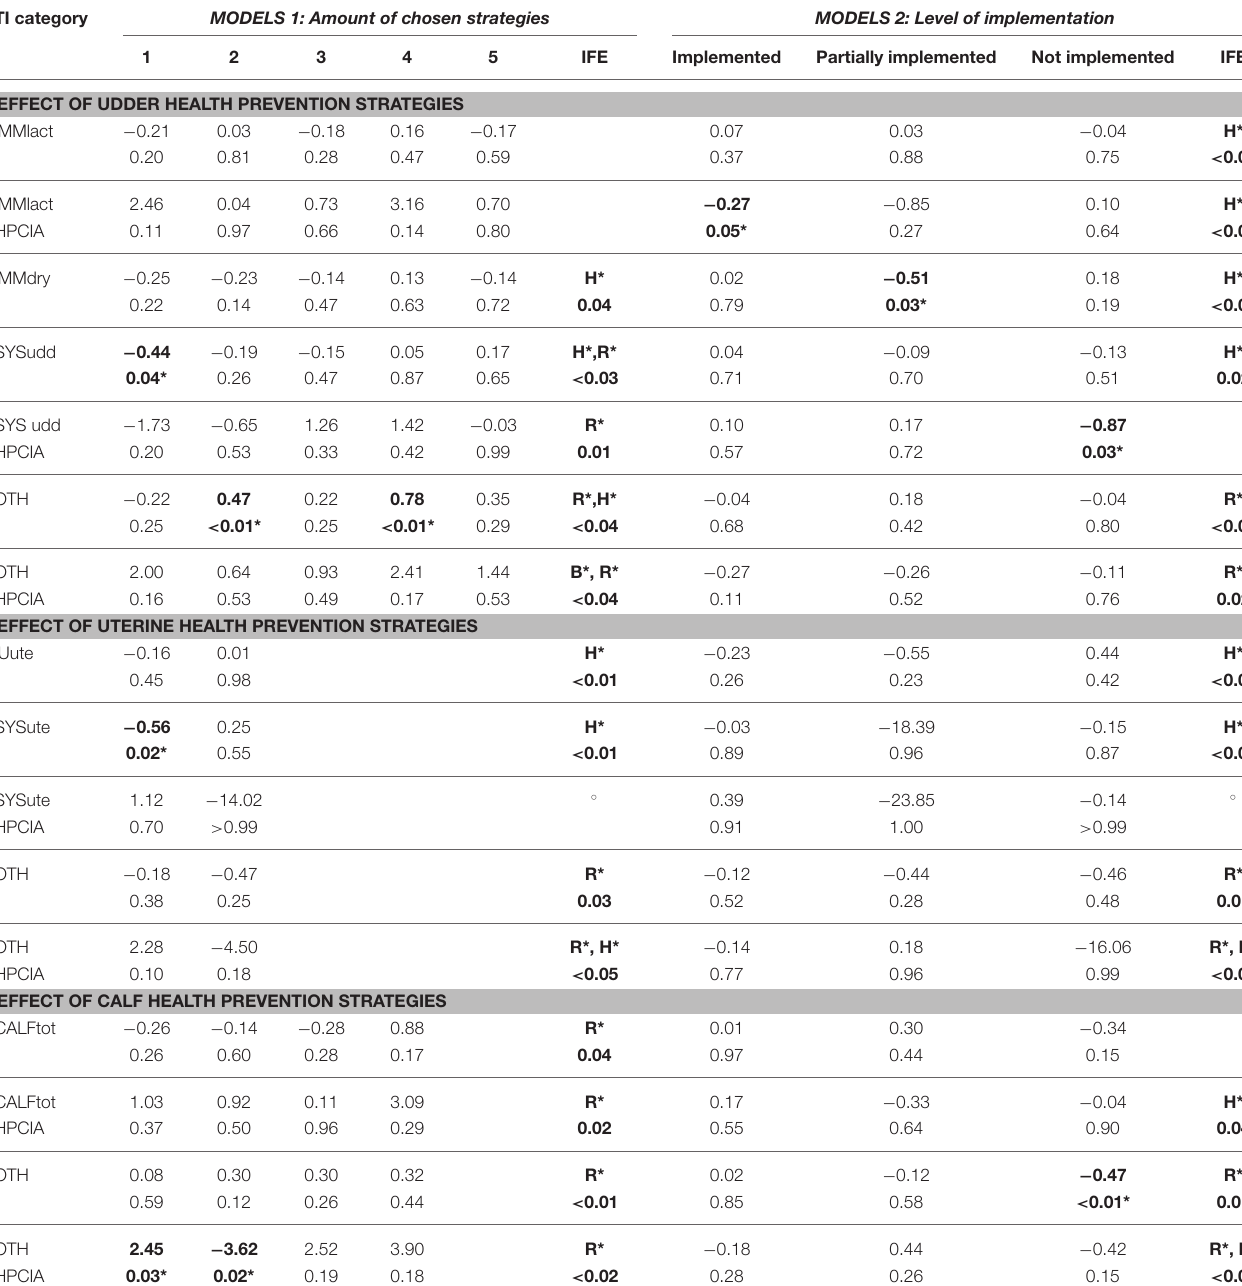
TABLE 5 | Estimates (upper line) and P -values (lower line) of the conditional mixed effect regression models investigating the association between treatment incidence and amount of chosen prevention strategies (Model 1), and between treatment incidence and implementation level of the strategies (Model 2, 1 = implemented, 2 = partially implemented, 3 = not